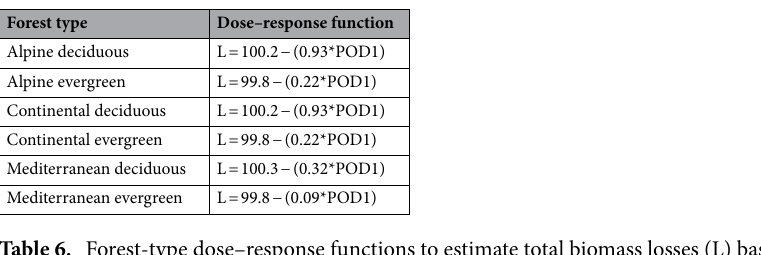
Table 6. Forest-type dose–response functions to estimate total biomass losses (L) based on the cumulated stomatal ozone flux above a threshold of 1 mmol m −2 (POD1) according to 6 .